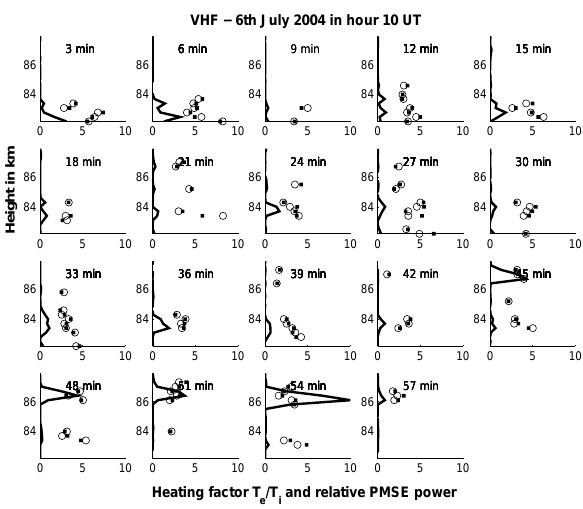
Fig. 9. As in Fig. 8, but now for hour 10:00 UT on 6 July 2004.